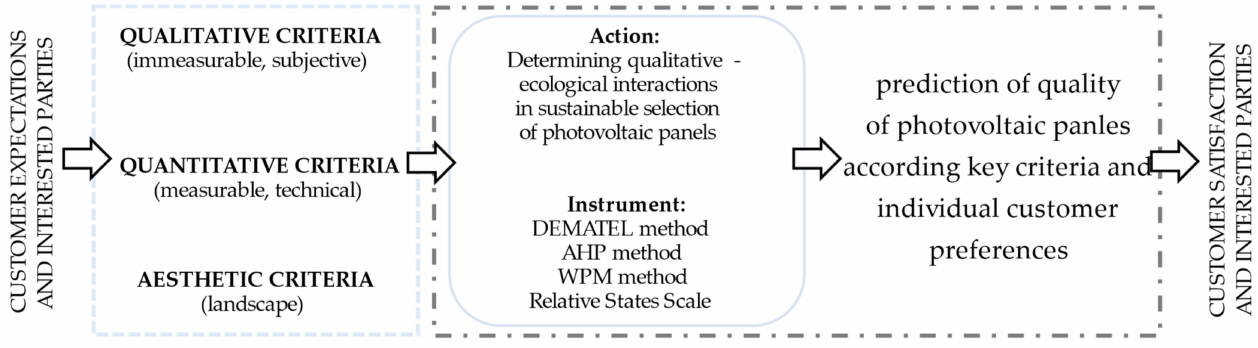
Figure 2. General concept of model. Own